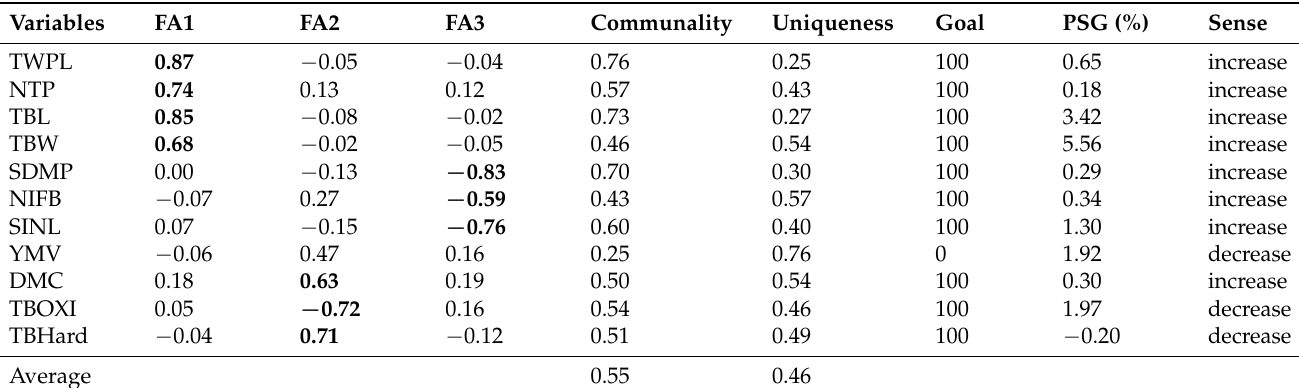
Table 4. Factorial loadings, communalities, uniqueness, and predicted genetic gains (PSG) based on the multi-trait genotype–ideotype distance index (Bold values represent traits with high contribution to each component).